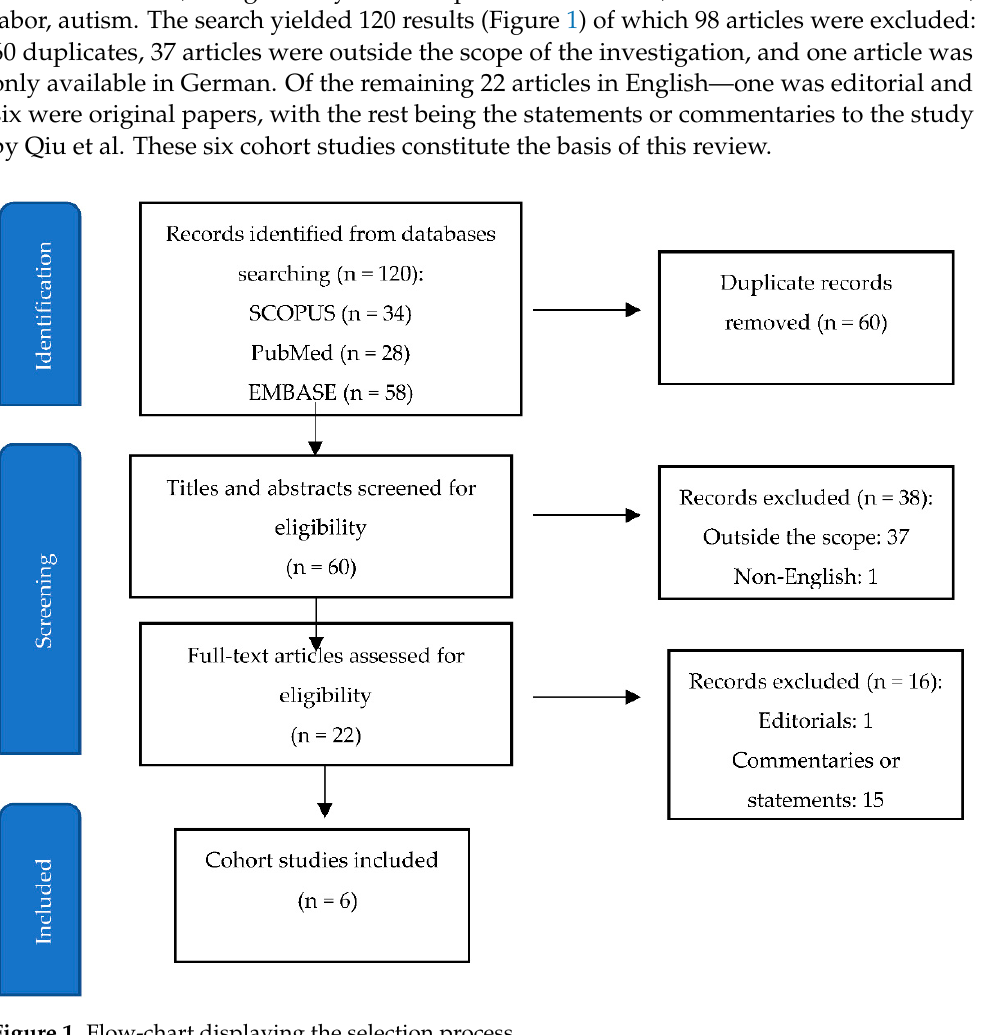
Figure 1. Flow-chart displaying the selection process.